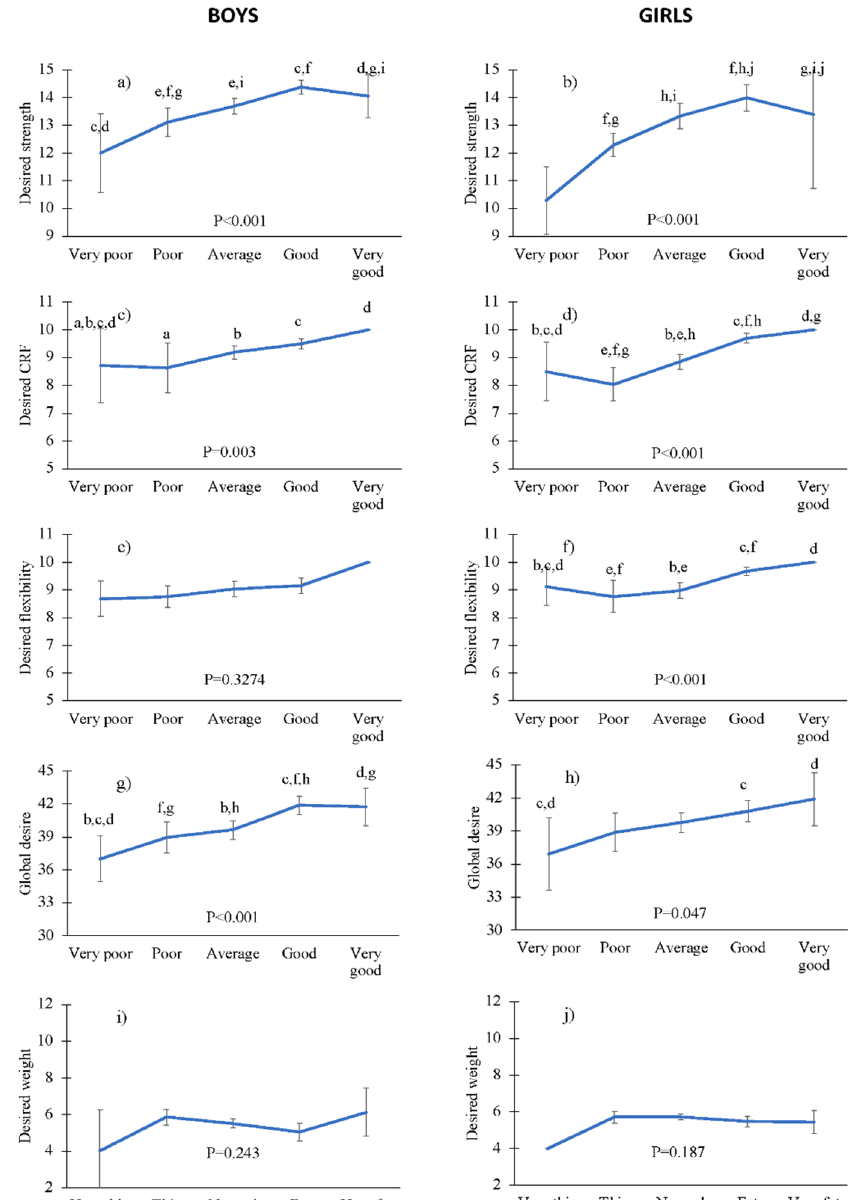
Figure 1. Associations between the perceived and the desired fitness, stratified by boys/girls (graphs a) through j)). Lowercase letters indicate significant differences ( p < 0.05) in post hoc Mann–Whitney test comparison between pairs: ( a ) very poor vs. poor; ( b ) very poor vs. average; ( c ) very poor vs. good; ( d ) very poor vs. very good; ( e ) poor vs. average; ( f ) poor vs. good; ( g ) poor vs. very good; ( h ) average vs. good; ( i ) average vs. very good; ( j ) good vs. very good.